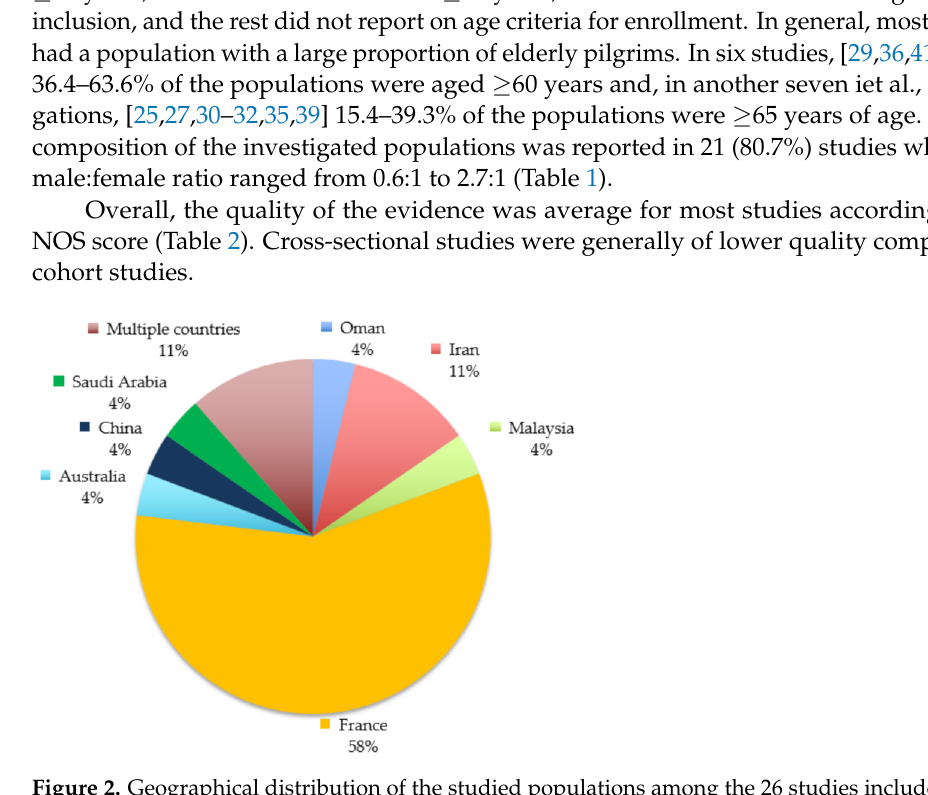
Figure 2. Geographical distribution of the studied populations among the 26 studies included in the systematic